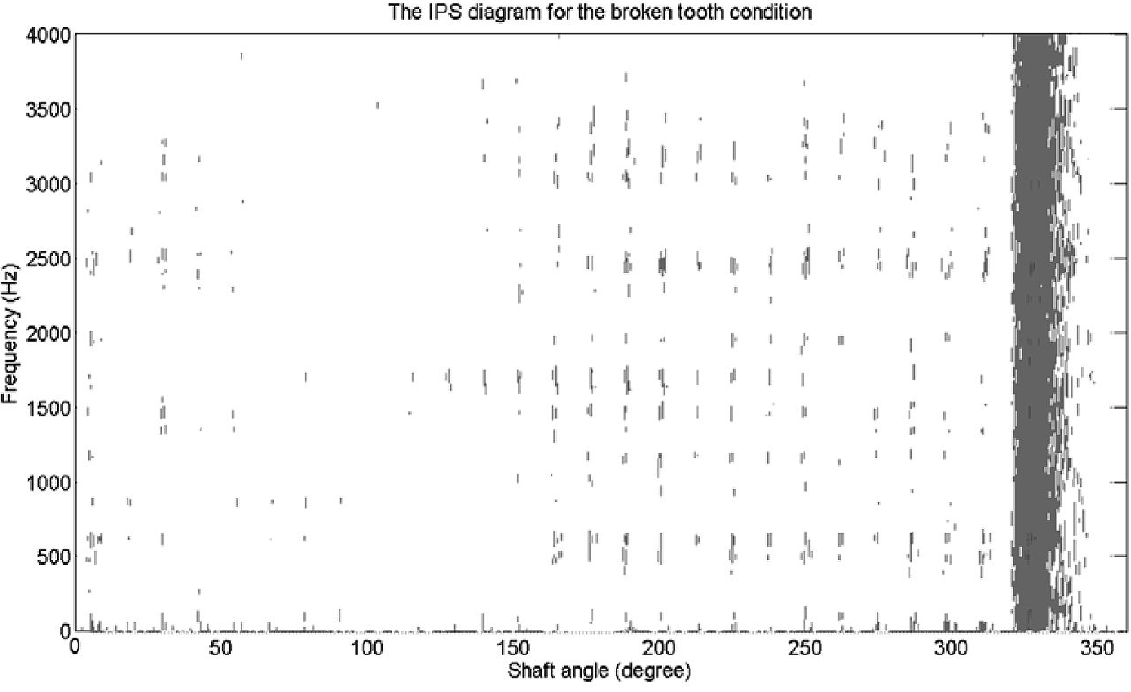
Fig. 9. IPS diagram for fully broken tooth